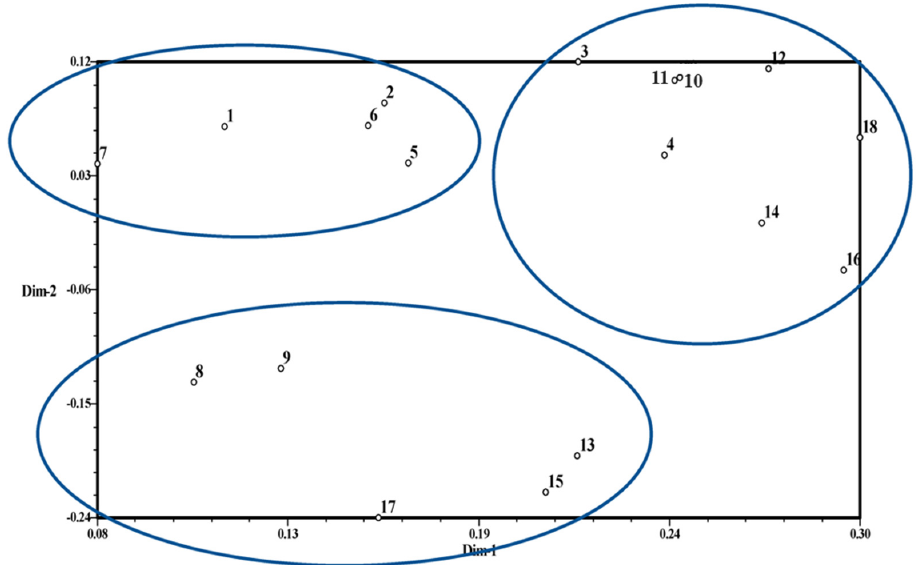
Figure 2. PCA (Principal Components Analysis) two − dimensional plot for 18 parsley genotypes using 181 iPBS markers.